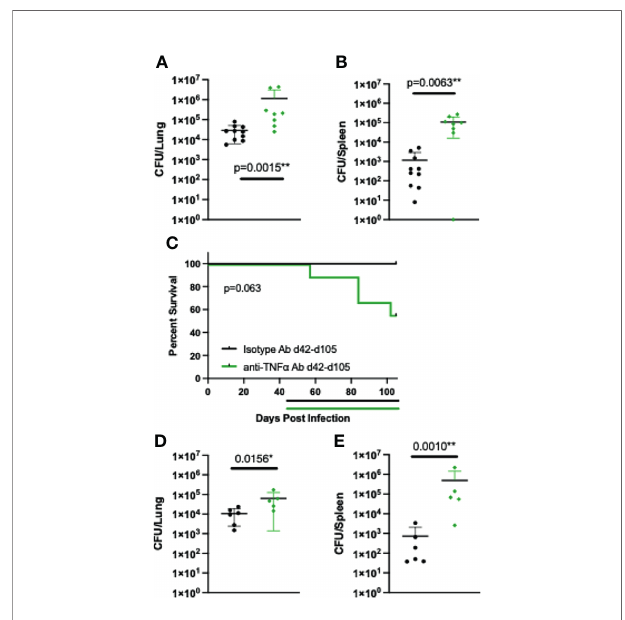
FIGURE 4 | Starting treatment of B6D2F1 with anti-TNF a antibody after infection is controlled still results in progressive Coccidioides disease. B6D2F1 mice were treated with 500 m g isotype control (black symbols) or anti-TNF a antibody (green symbols) starting on day 42 after infection with ~50 arthroconidia of Cp1038; dosing was continued on an alternating q3/4d schedule. And 28 days after the start of anti-TNF a therapy, a subset of mice (n = 8/group) was sacri fi ced, and lung (A) and spleen (B) fungal burdens were determined by serial dilution. The remaining mice (n = 10/group) were followed for disease progression (C) . Treatment timelines are indicated by colored lines below the survival graph. Data are represented as mean with standard deviation. At the planned end of the experiment (105 days), surviving mice were sacri fi ced and lung (D) and spleen (E) fungal burdens were determined by serial dilution. Differences in fungal burden were tested for signi fi cance using a Kruskal – Wallis on log-transformed data. Survival differences were determined using Mantel –